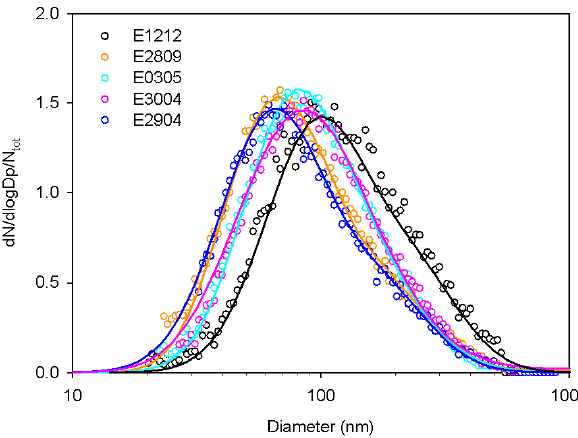
Fig. 3. Dry size distributions concentration for ammonium sulfate particles normalized by total number concentration ( N tot ) in the smog chamber before the injection of water